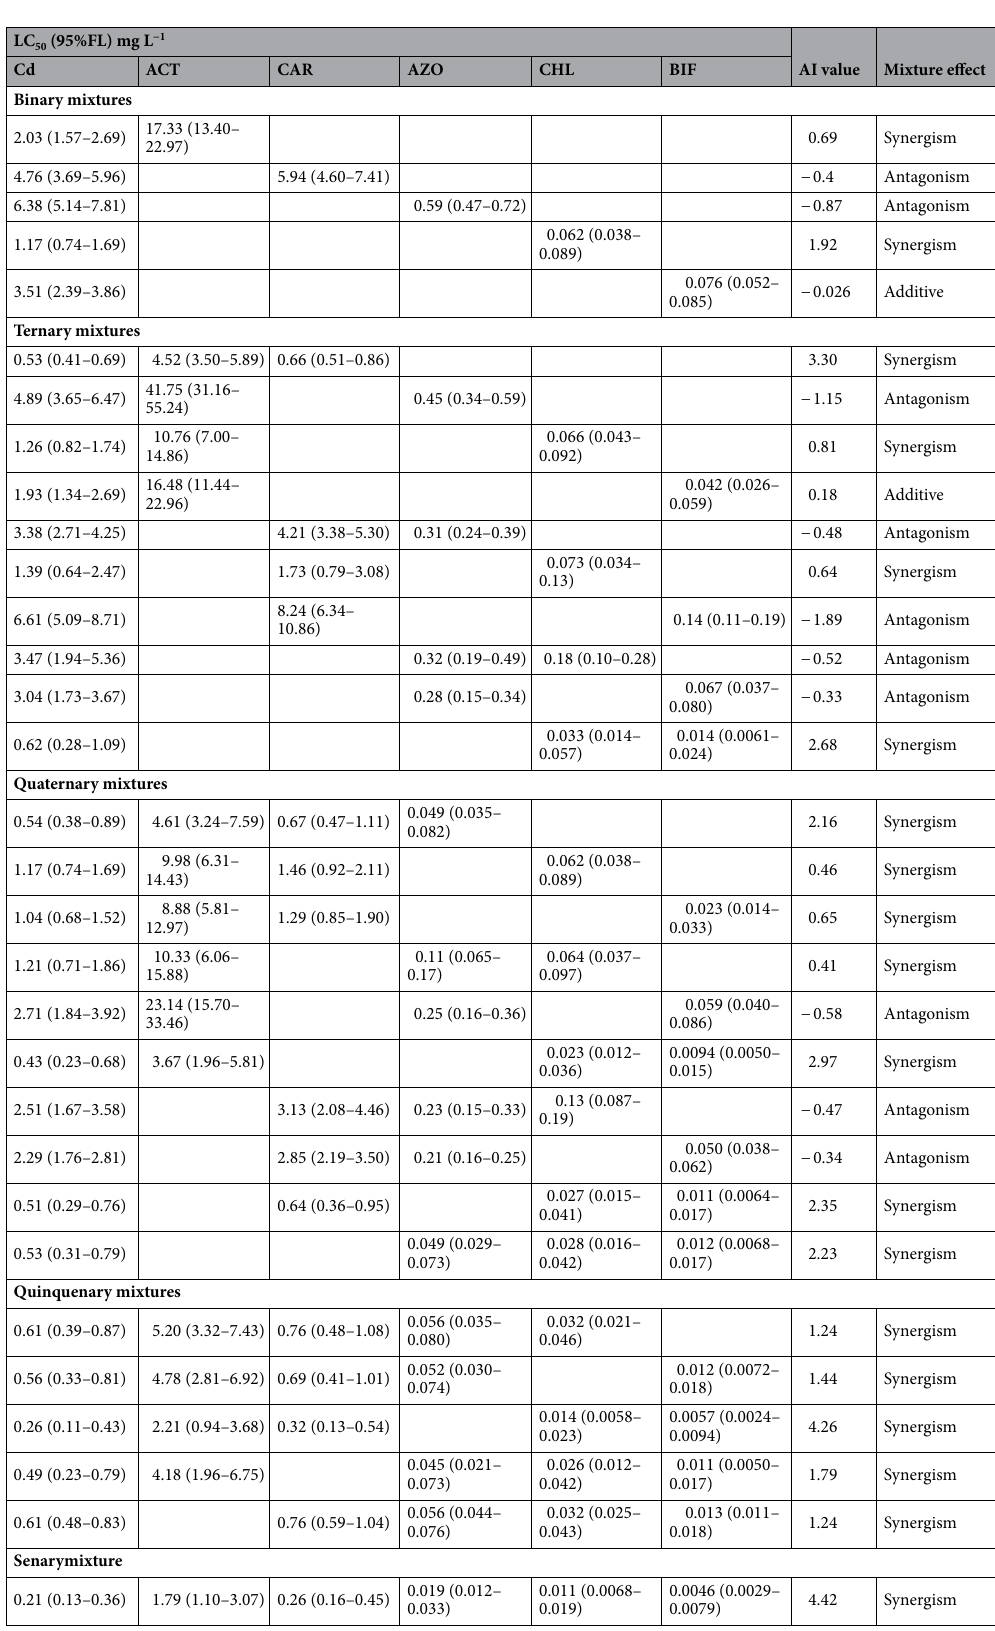
Table 3. Mixture toxicity of Cd and five pesticides with equitoxic ratio to the larvae of D. rerio . FL fiducial limit, AI additive index, ACT acetamiprid, CAR carbendazim, AZO azoxystrobin, CHL chlorpyrifos, BIF